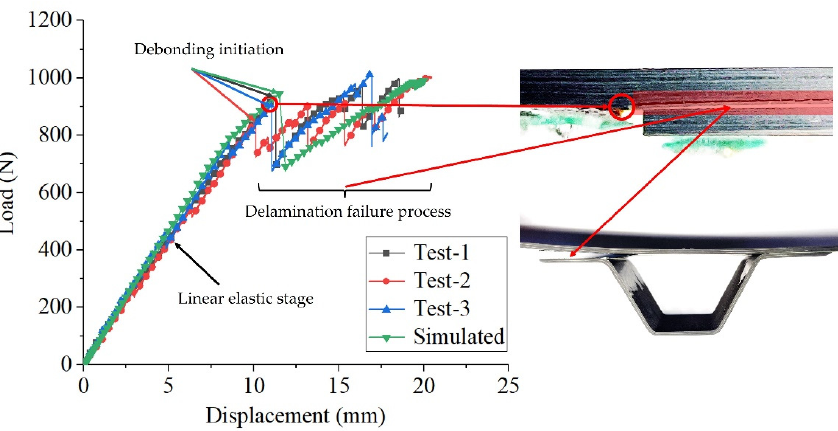
Figure 9. Load-displacement curves of the static tests and comparison with numerical result.